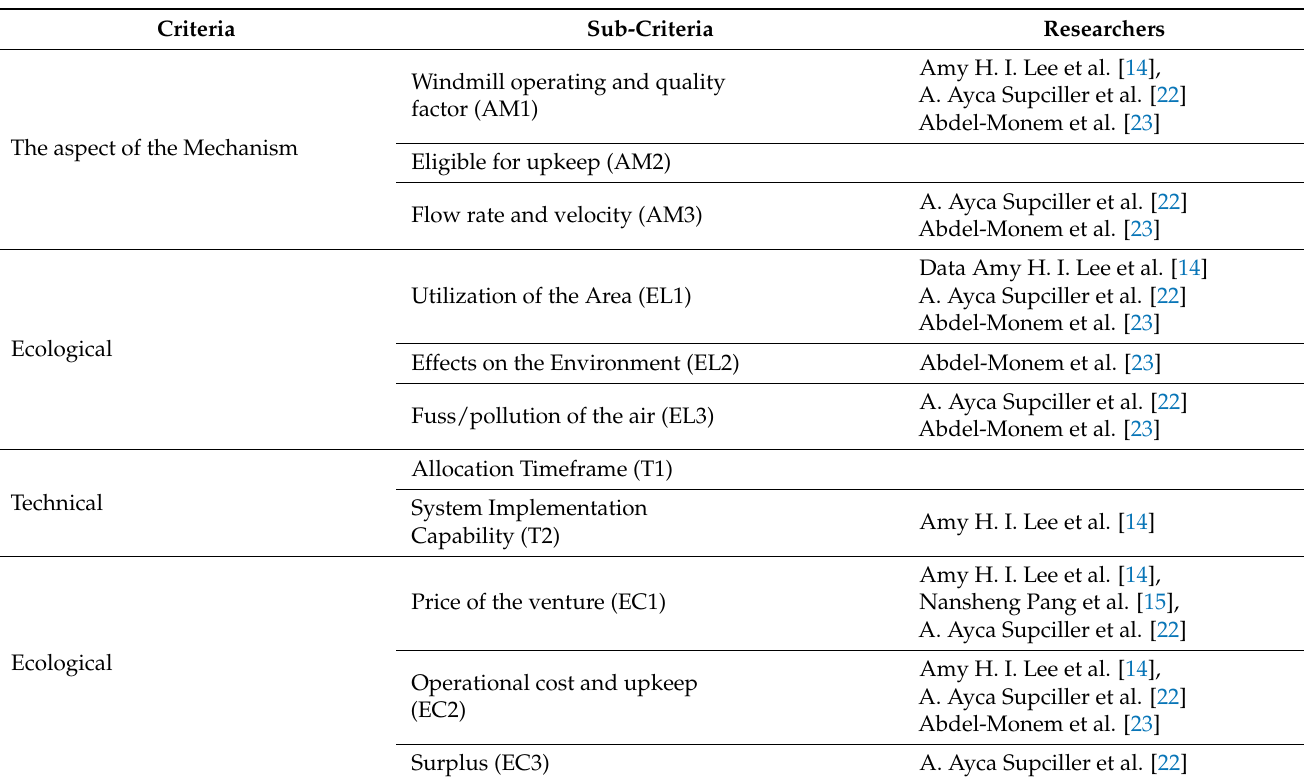
Table 3. Criteria used for the supplier